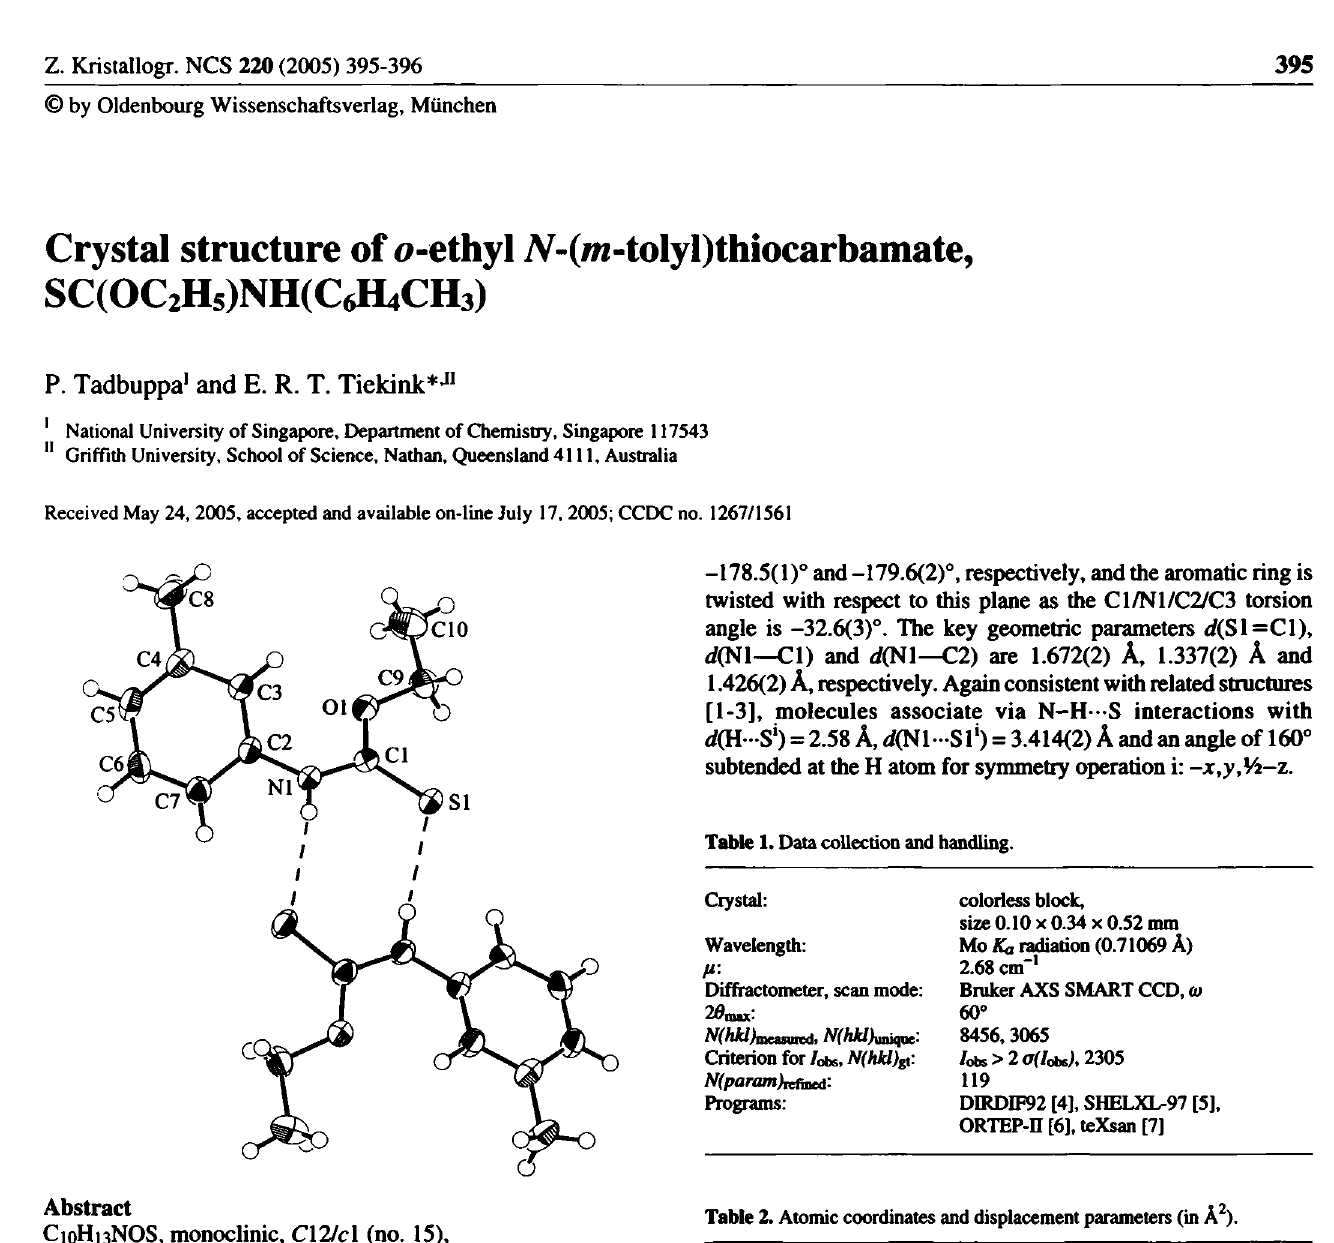
Table 2. Atomic coordinates and displacement parameters (in A 2